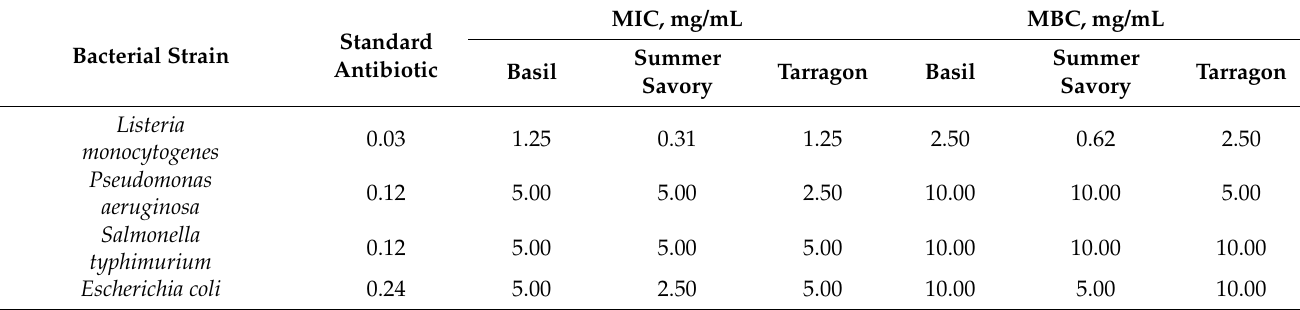
Table 1. Minimum inhibitory concentration (MIC) and minimum bactericidal concentration (MBC) of basil, summer savory, tarragon and streptomycin against bacterial strains tested with the microdilution method. Standard Bacterial Strain